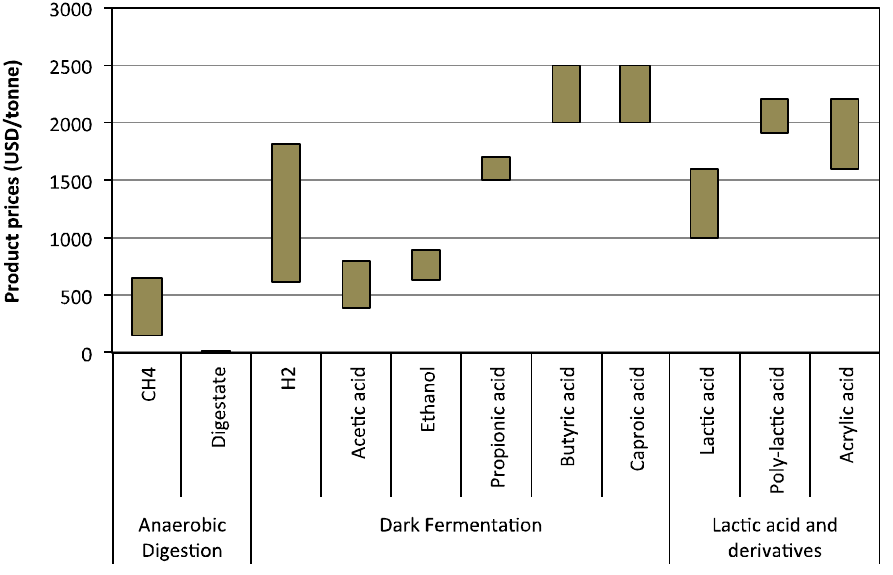
Figure 1. Market price ranges of main anaerobic-fermentation-based products.